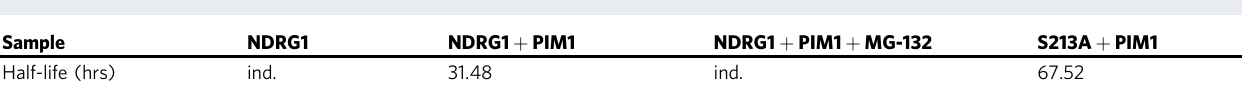
Table 1 Projected half-lives for